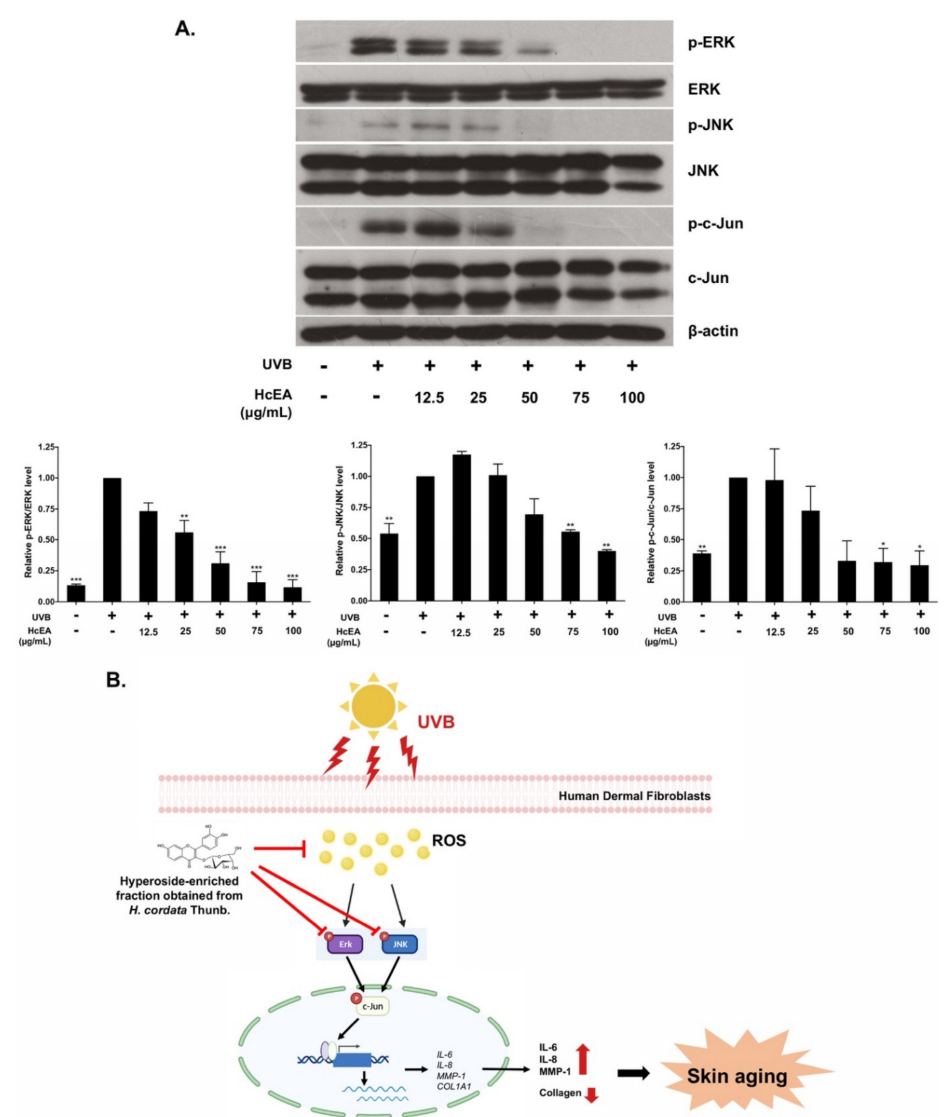
Figure 6. The HcEA fraction inhibited MAPK signaling pathway and AP-1 activation in UVB-irradiated fibroblast cells. UVB- irradiated fibroblasts were treated with HcEA for 24 h. Cells were kept and determined for the phosphorylation of the MAPK proteins (ERK and JNK) and activation of AP-1 transcription factor (c-JUN) using western blot analysis ( A ). The mechanism